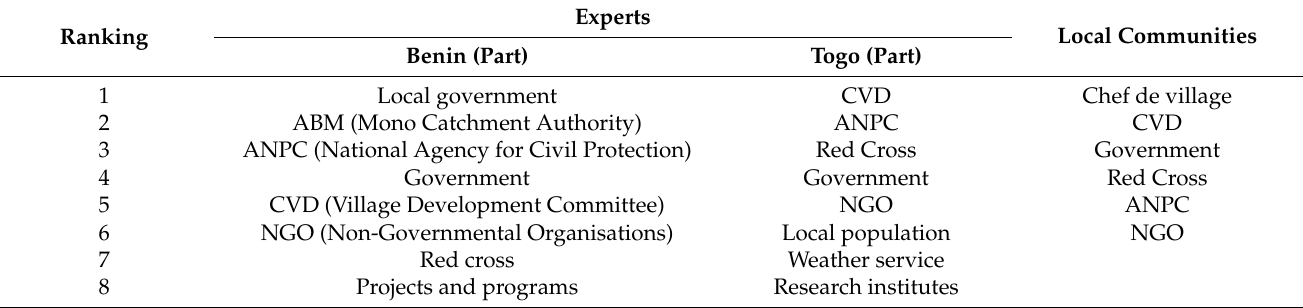
Table 3. Ranking of indirect actors according to experts and local communities.